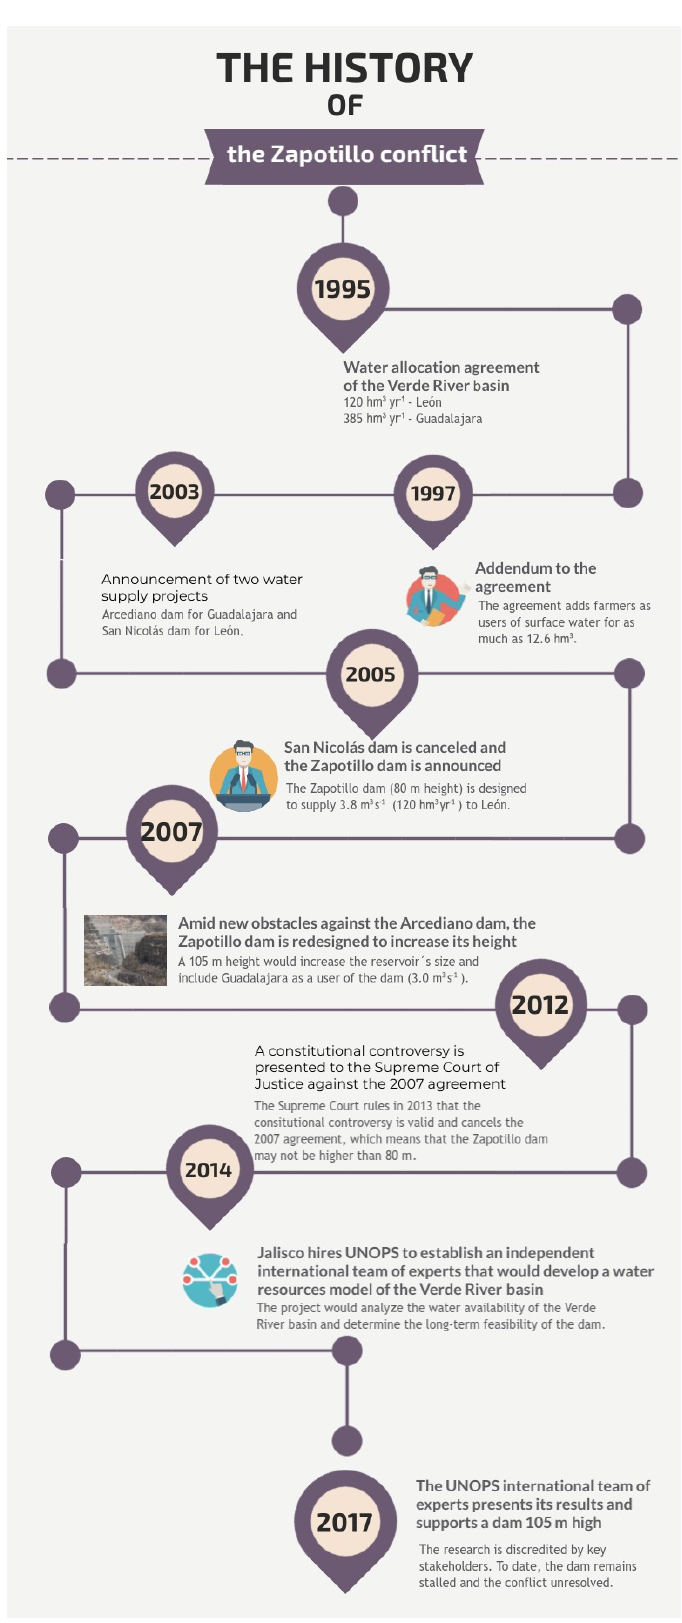
Figure 3. Timeline of the Zapotillo